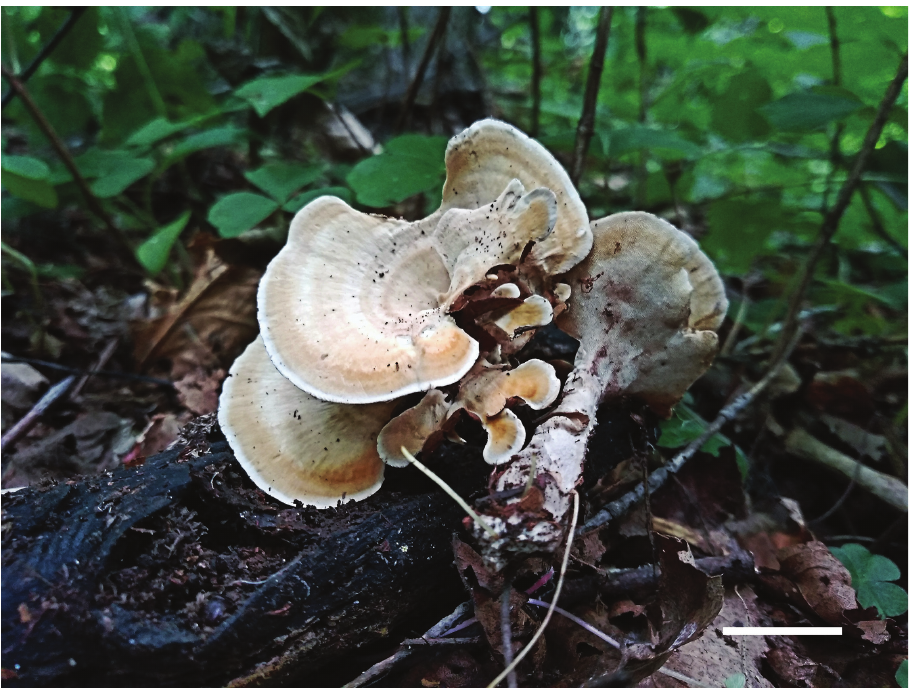
Figure 2. Basidiocarps of Mycorrhaphium subadustum (IFP 019374, holotype). Scale bar: 10 mm.